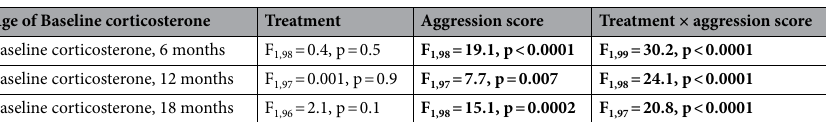
Table 2. Results of generalized linear mixed models (GLMM) analyzing the response to treatment (control or 5 ng corticosterone), aggression score, and their interaction on baseline corticosterone concentrations. Bold values indicate p <